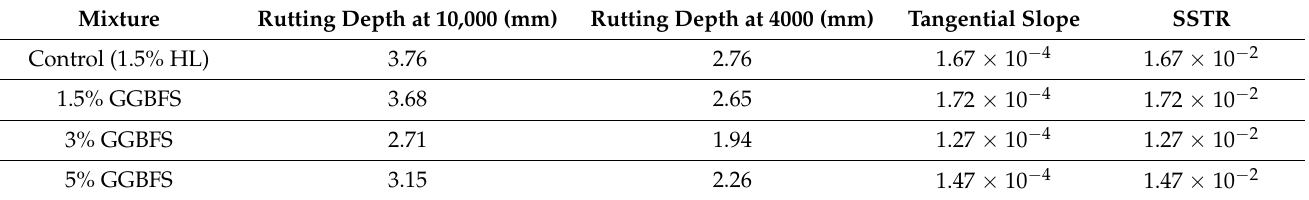
Table 12. Rutting Test